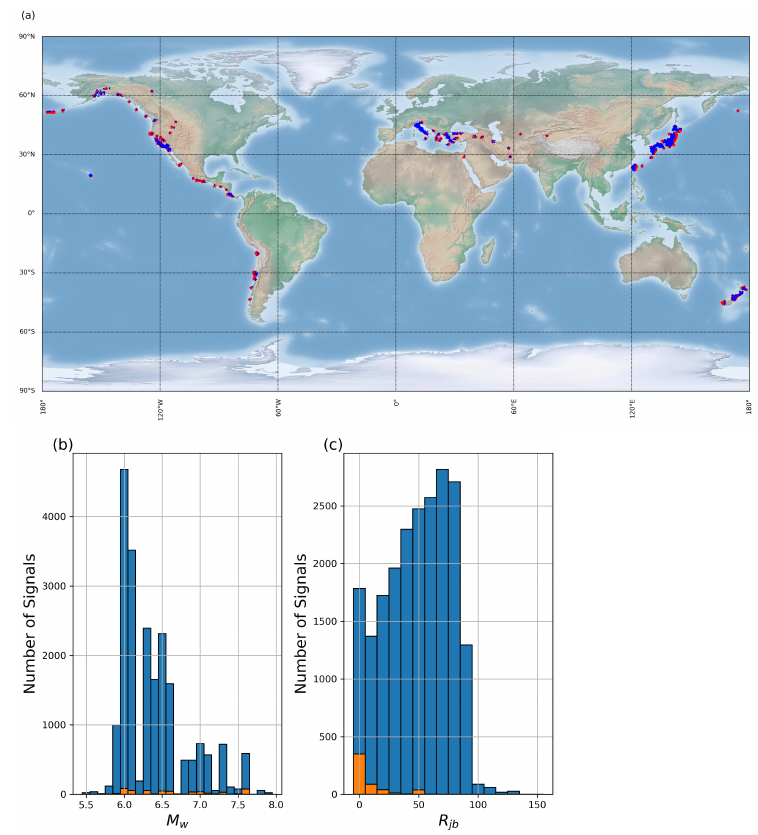
Figure 1. ( a ) The distribution of earthquakes (red stars) and stations (blue dots); ( b ) a histogram of the number of manually detected impulsive (orange) and non-impulsive (blue) signals with M w with a 0.1 interval; ( c ) a histogram of the number of impulsive and non-impulsive signals with epicentral distance with a 10km